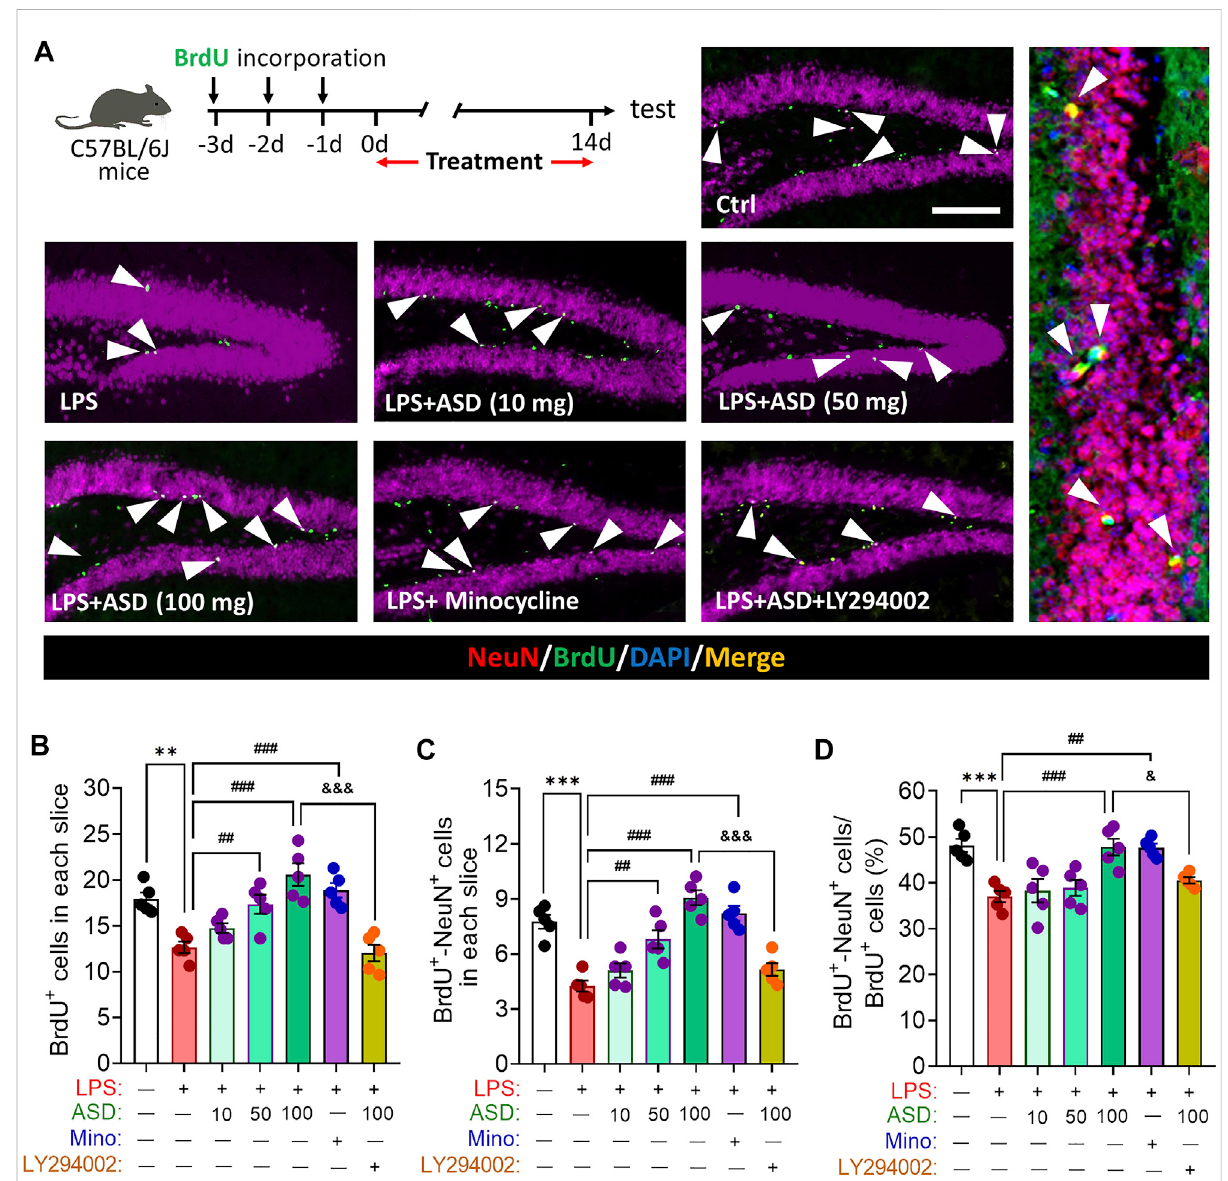
FIGURE 5 Effects of ASD on survival and maturation of newborn neurons in dentate gyrus of mice chronically exposed to LPS. (A) , Timeline for evaluating newborn neuron survival and maturation based on immuno fl uorescence micrographs of BrdU + -NeuN + cells in the dentate gyrus of mice. Surviving cells were labelled with BrdU (green); mature neurons, with antibody against neuron-speci fi c nucleoprotein (NeuN); and mature neurons differentiated from NSPCs, with both BrdU and anti-NeuN antibody (white arrowheads). Scale bar, 100 μ m. (B) , Quanti fi cation of hippocampal BrdU+cellsineachslice. (C) ,Quanti fi cationofhippocampalBrdU+-NeuN+cellsineachslice. (D) ,Quanti fi cationofthepercentageoftotalBrdU+ cells in DG that were BrdU + -NeuN+. Five mice from each group were examined, and fi ve hippocampal micrographs (40×) from each animal were quanti fi ed. Each dot in the bar graph represents the average of all micrographs for each mouse. Data are mean ± standard error of the mean (SEM) (n=5),** p < 0.01,*** p < 0.001 vs.Ctrlgroup, ## p < 0.01,### p < 0.001 vs.LPSgroup, & p < 0.05,&&& p < 0.001vs.ASD(100 mg/kg)+LPSgroupby one-way ANOVA with Tukey ’ s multiple-comparisons